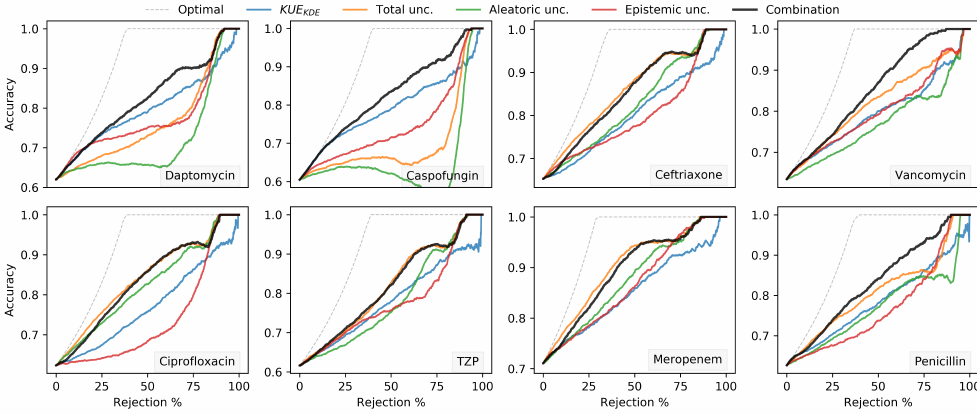
Figure 4. AR curves for aleatoric, epistemic and total uncertainty for the Bacteria dataset. The curve for perfect rejection is included as a baseline. The name in each plot represents the antibiotic name used for each OOD inputs